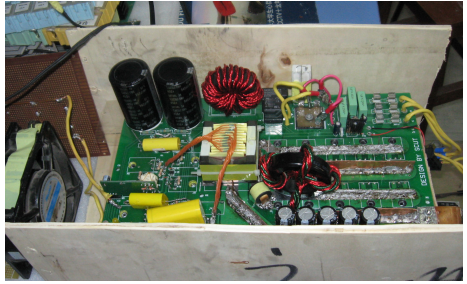
Figure 8. The prototype and experimental environment.